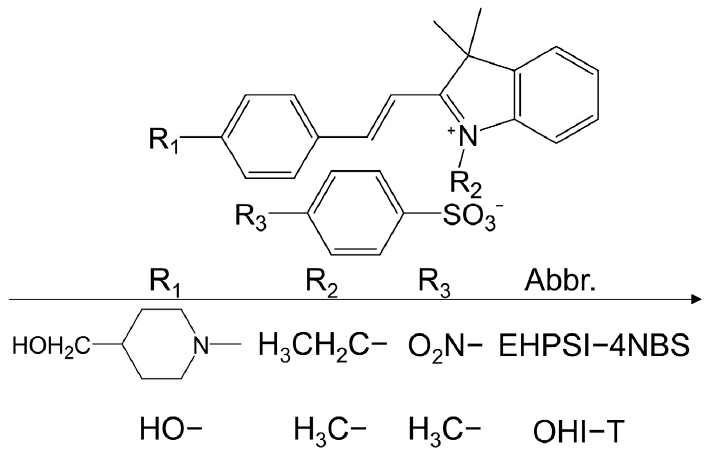
Figure 12. Chemical structures of indolium-based EHPSI-4NBS and OHI-T.